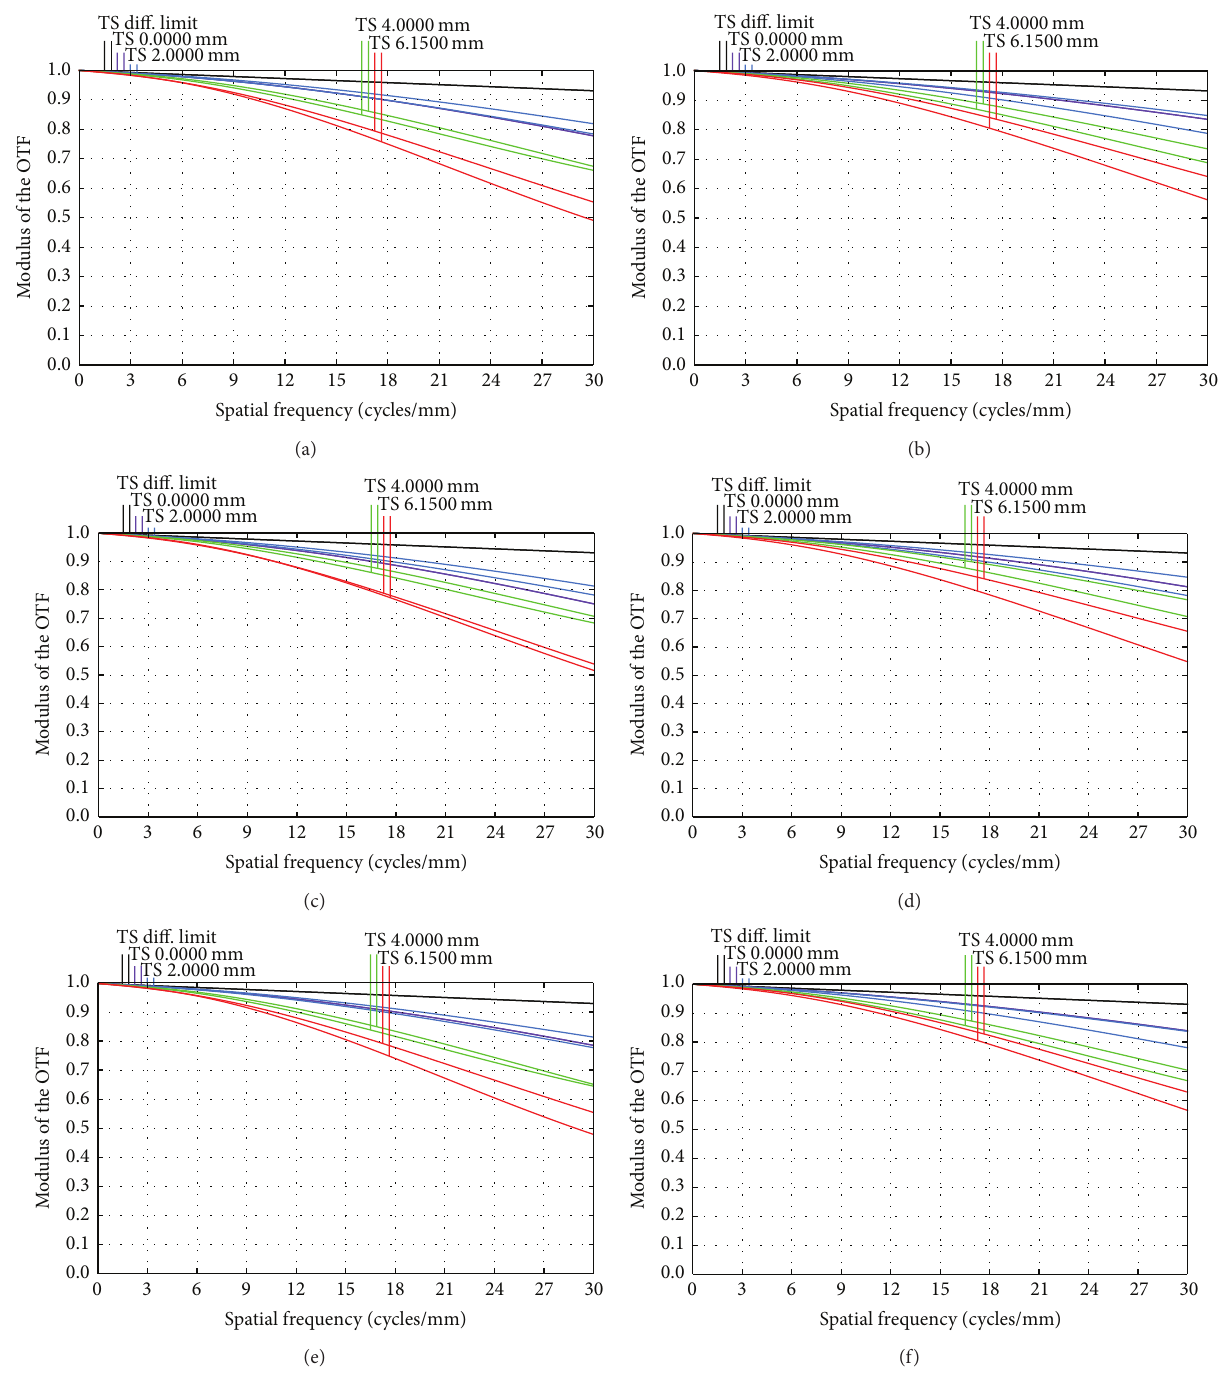
Figure 13: Polychromatic MTF for 420 nm to 1700 nm: (a) original design at 20 ∘ C, (b) final design at 20 ∘ C, (c) original design at − 20 ∘ C, (d) final design at − 20 ∘ C, (e) original design at 60 ∘ C, and (f) final design at 60 ∘